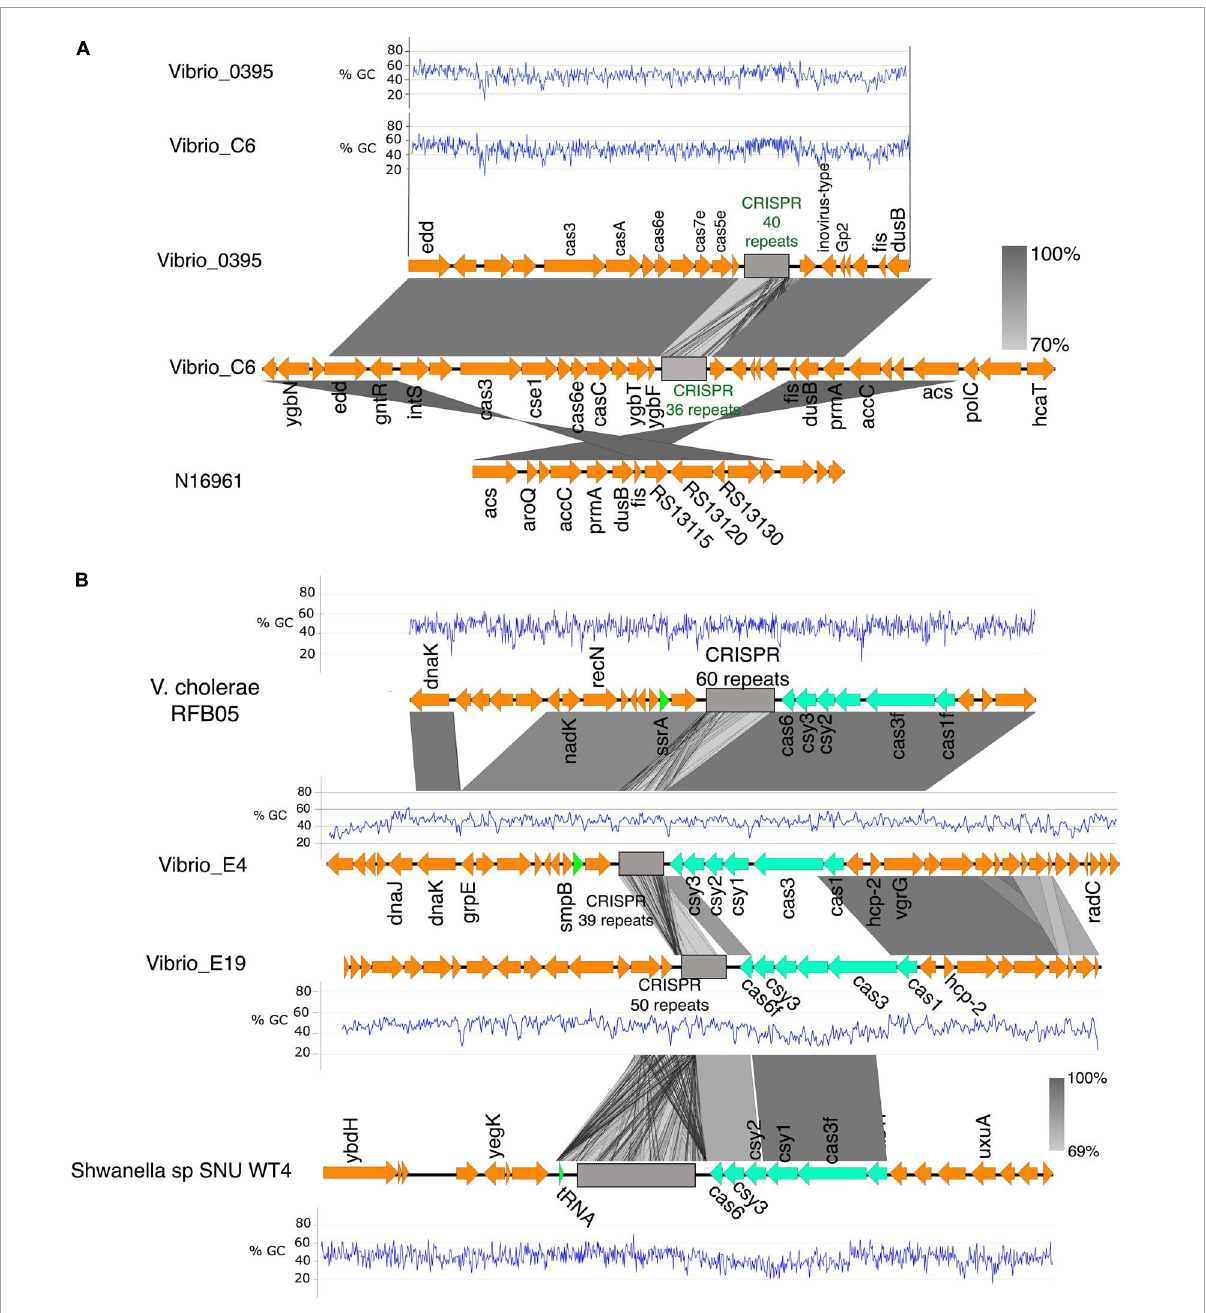
FIGURE5 The CRISPR-Cas system in V. cholerae isolates. (A) The CRISPR-Cas system and alignment of the region in the clinical isolate C6, V. cholerae 0395, and the N16961. The C6 harbors a type I-E CRISPR-cas system homologous to the one in V. cholerae 0395 with similar GC% patterns of the cas genes. The region flanking the CRISPR-Cas system in the C6 is conserved in the N16961. (B) Genetic organization of the CRISPR-Cas loci in the environmental isolate E4 and E19 and their alignment with V. cholerae RFB05 and Shewanella sp SNU WT4 . The type I-F CRISPR-Cas system in E4 is homologous to the one in V. cholerae RFB05. The type I-F CRISPR-Cas system in the E19 is homologous to the one in Shewanella sp . SNU WT4 and shares almost similar GC%, which is anomalously low and probably acquired by lateral gene transfer (%GC of Cas genes in E19 is 41% compared to the overall GC% of 47.7% in E19. The grayscale bars show the nucleotide homology in the aligned